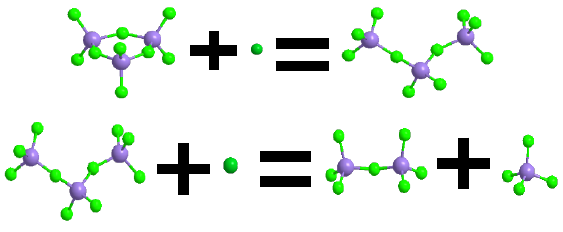
Figure 17. Schematic diagram of Equations (2) and (3).